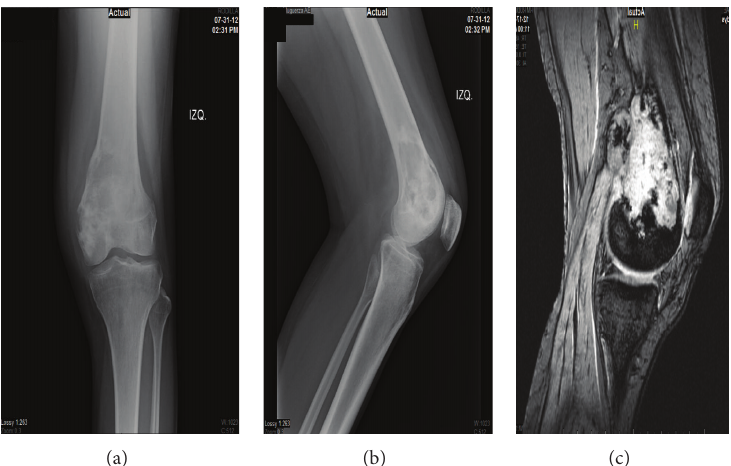
Figure 1: ((a) and (b)) Permeative pattern in distal femur; (c) malignant looking lesion is corroborated with a MRI. MRI: magnetic resonance imaging.